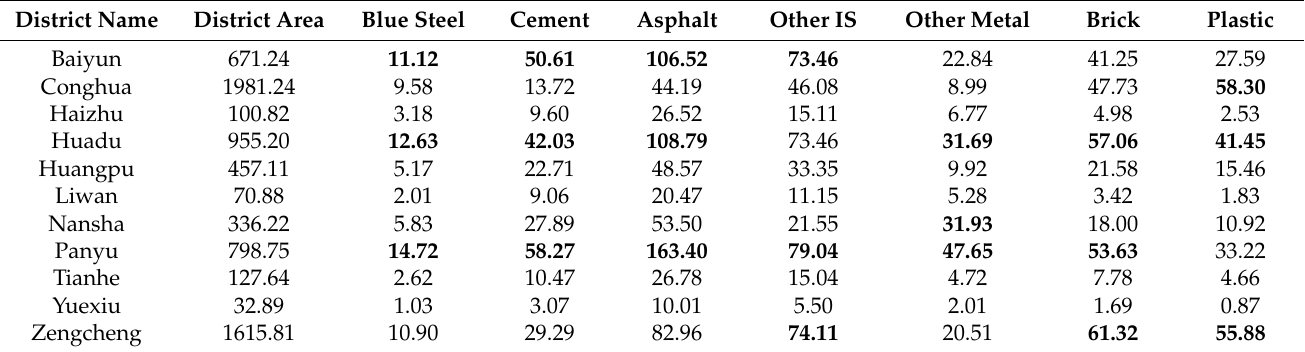
Table 3. Distribution and area of each class in the districts of